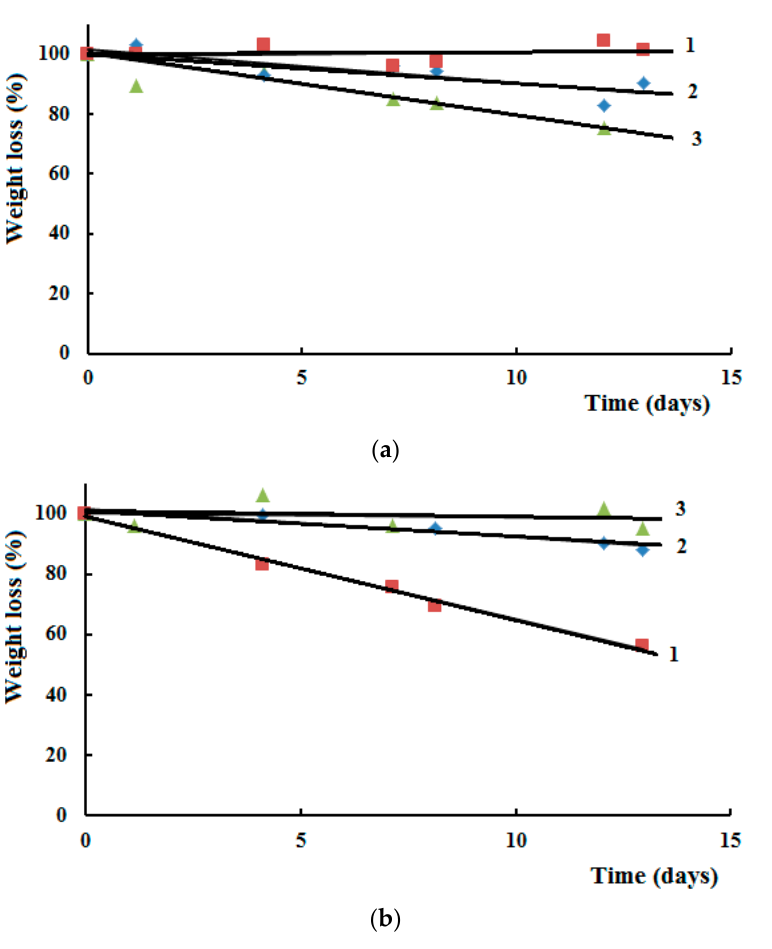
Figure 10. Weight loss of hydrogels with time in various dispersion media: saline solution ( a ) or PBS ( b ), immersed in saline solution (1), distilled water (2), PBS (3). Data are expressed as mean ± SD; n = 3.